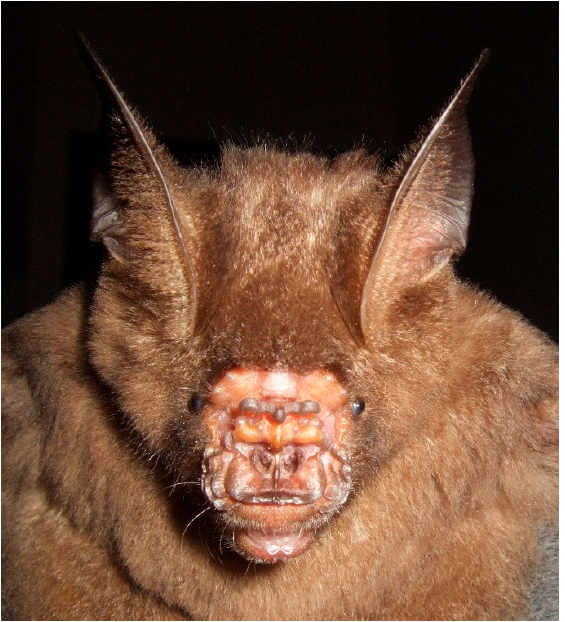
Figure 12. Hipposideros armiger , adult male. Photograph by Vu Dinh Thong.